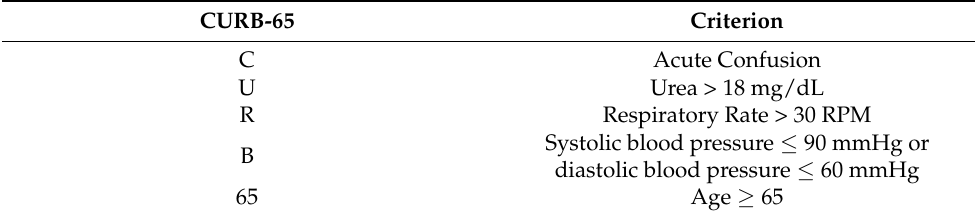
Table 2. CURB-65 criteria: Each item in the CURB-65 criteria scores 1 point. Hospital admission is recommended if the patient has a total score greater than or equal to 1